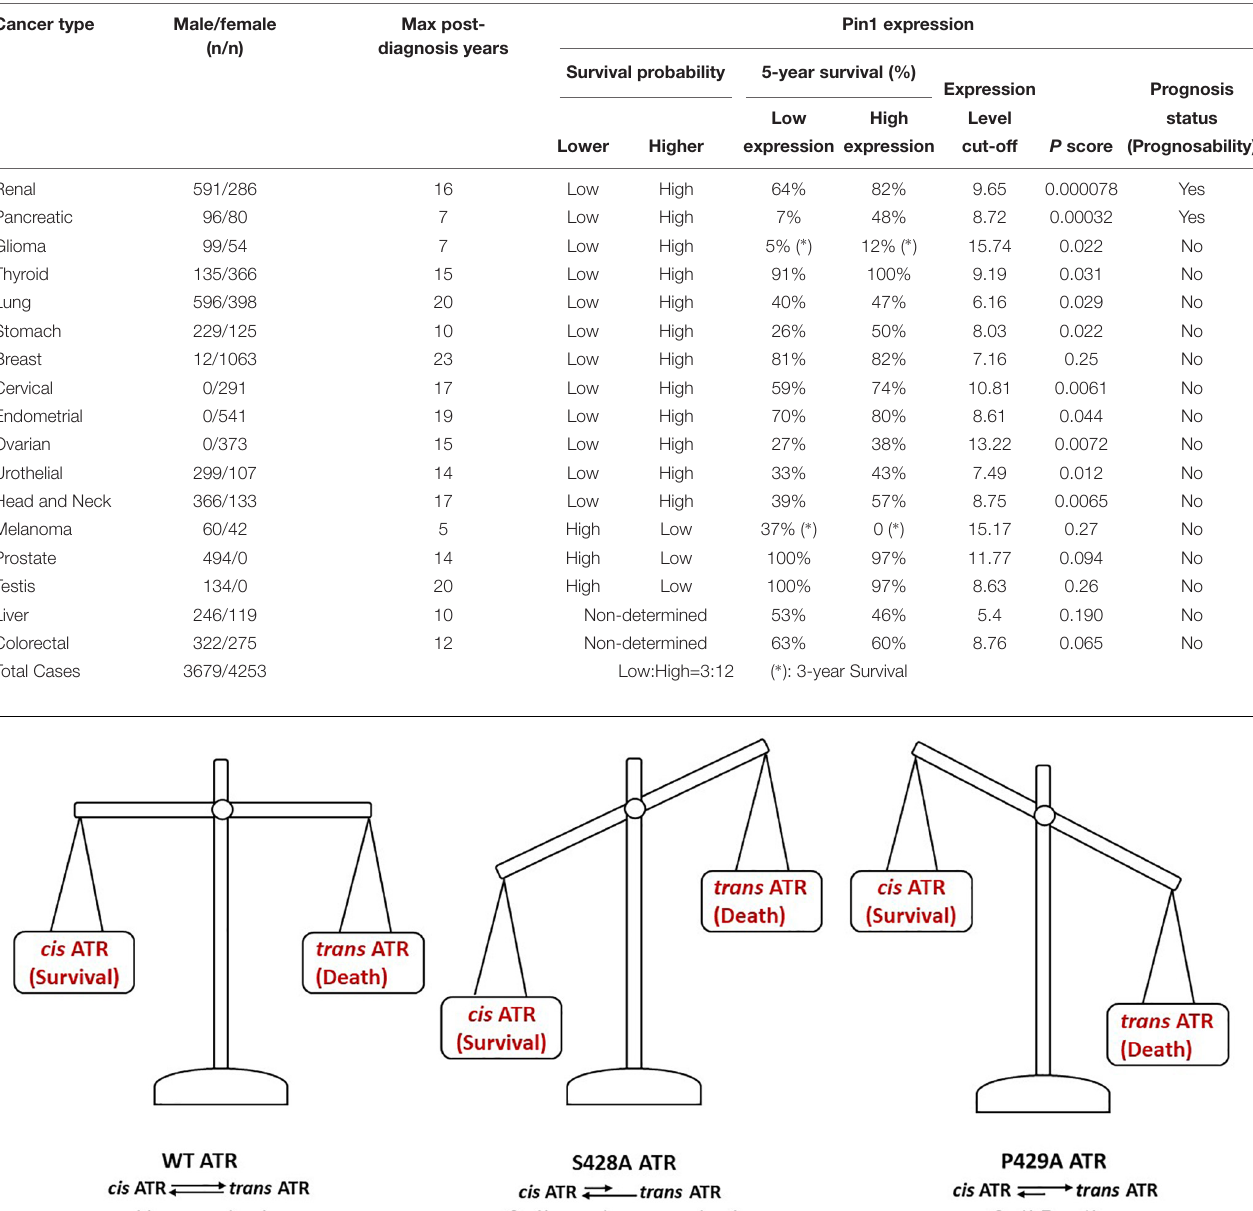
TABLE 1 | Pin1 RNA expression in caner patients analyzed by Kaplan-Meier Plot (Human Protein Atlas). Cancer type